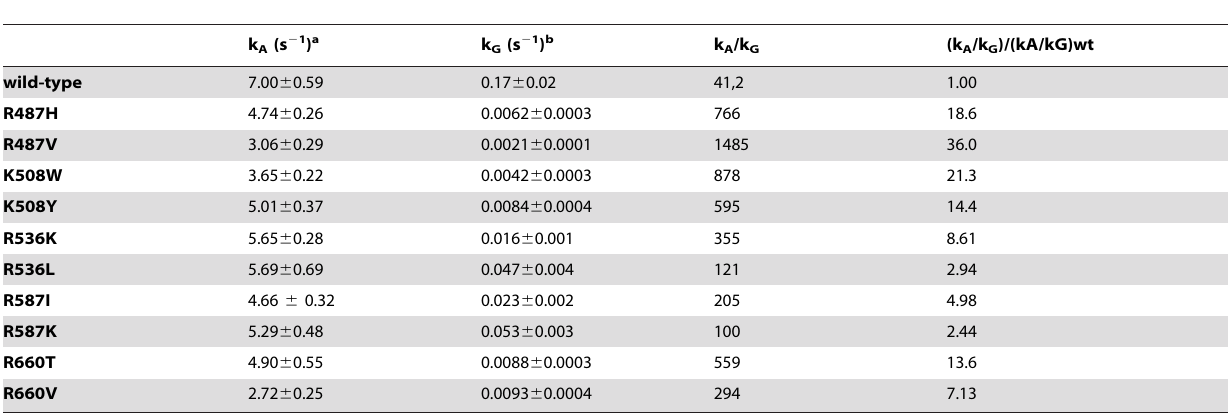
Table 1. Single turnover rates with std. error (pre-steady-state) of KlenTaq wild-type (wt) and